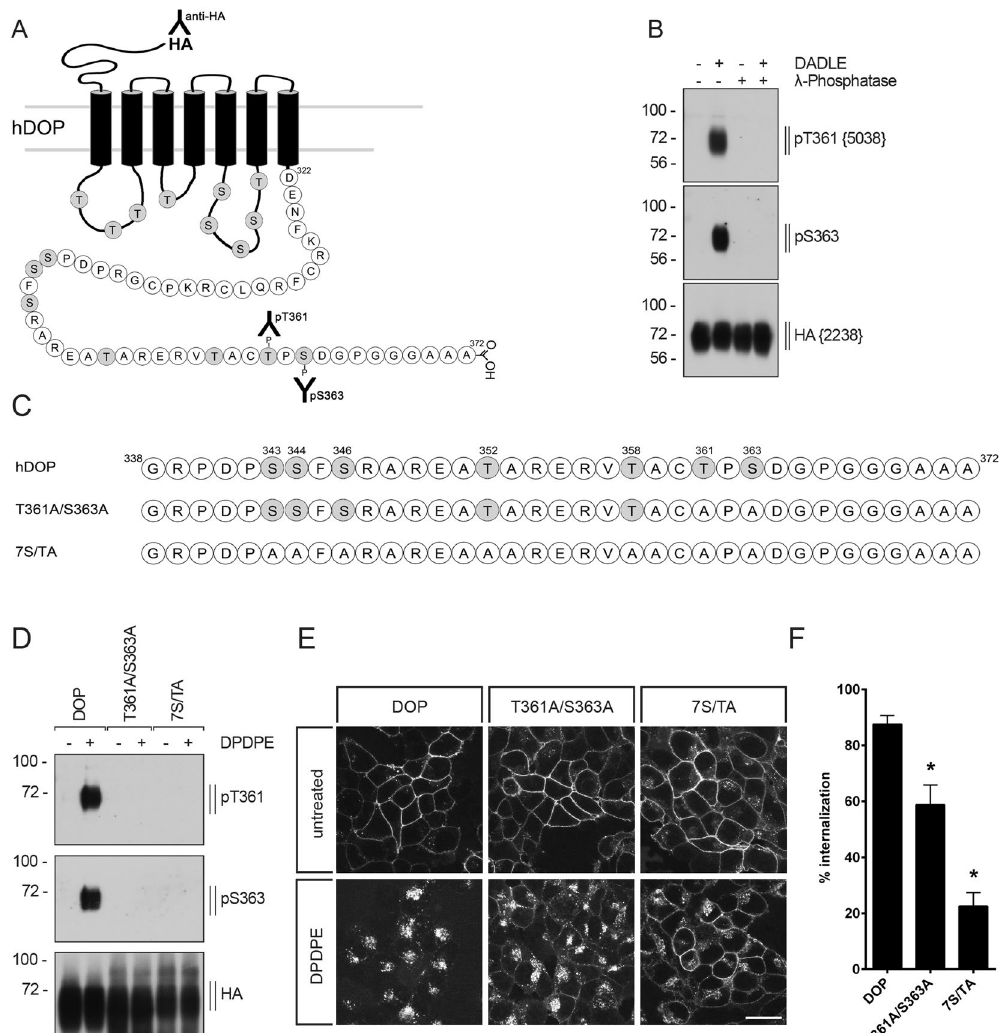
Figure 1. Characterization of phosphosite-specific DOP receptor antibodies using λ -phosphatase and receptor mutants. ( A ) Schematic representation of the human DOP receptor (hDOP). Potential intracellular phosphorylation sites are depicted in gray. T361 was targeted for the generation of the phosphosite-specific anti-pT361 antibody and anti-pS363 antibody was acquired commercially. (B) Characterization of phosphosite- specific antibodies directed against T361 and S363 using λ -phosphatase. Stably HA-tagged hDOP-receptor expressing HEK293 cells were either not treated ( − ) or treated ( + ) with 10 µ M DADLE for 10 min. Lysates were then either not incubated ( − ) or incubated ( + ) with λ -phosphatase and immunoblotted with the phosphosite-specific antibodies anti-pT361 {5038} or anti-pS363. Blots were stripped and reprobed with the anti-HA antibody {2238} as a loading control. Blots are representative, n = 3. Molecular mass markers (kDA) are indicated, left. (C) Sequence of the carboxyl-terminal tail of hDOP receptor showing all potential phosphorylation sites. Serine (S) and threonine (T) residues indicated were exchanged to alanine. (D) HEK293 cells stably expressing HA-hDOP receptor, T361A/S363A or 7 S/TA were not treated ( − ) or treated ( + ) with 1 µ M DPDPE for 10 min and lysates were immunoblotted with the antibodies to pT361 or pS363. Blots were stripped and reprobed with the anti-HA antibody. Blots are representative, n = 5. (E) Cells described in (D) were preincubated with antibody to HA-tag and subsequently exposed to 10 µ M DPDPE or vehicle for 30 min at 37 °C. Cells were fixed, permeabilized, immunofluorescently stained and examined using confocal microscopy. Images are representative from one of three independent experiments. Scale bar, 20 µ m. (F) Receptor internalization was quantified by ELISA. Cells described in (D) were preincubated with antibody to HA-tag and stimulated with 10 µ M DPDPE or vehicle at 37 °C for 30 min. Cells were fixed and labeled with a peroxidase- conjugated secondary antibody. Receptor internalization was measured by enzyme-linked immunosorbent assay and quantified as the percentage of internalized receptors in DPDPE-treated cells. Data are mean ± SEM of five independent experiments performed in quadruplicate. Results were analyzed by one-way ANOVA followed by Bonferroni’s post-hoc test ( * p <